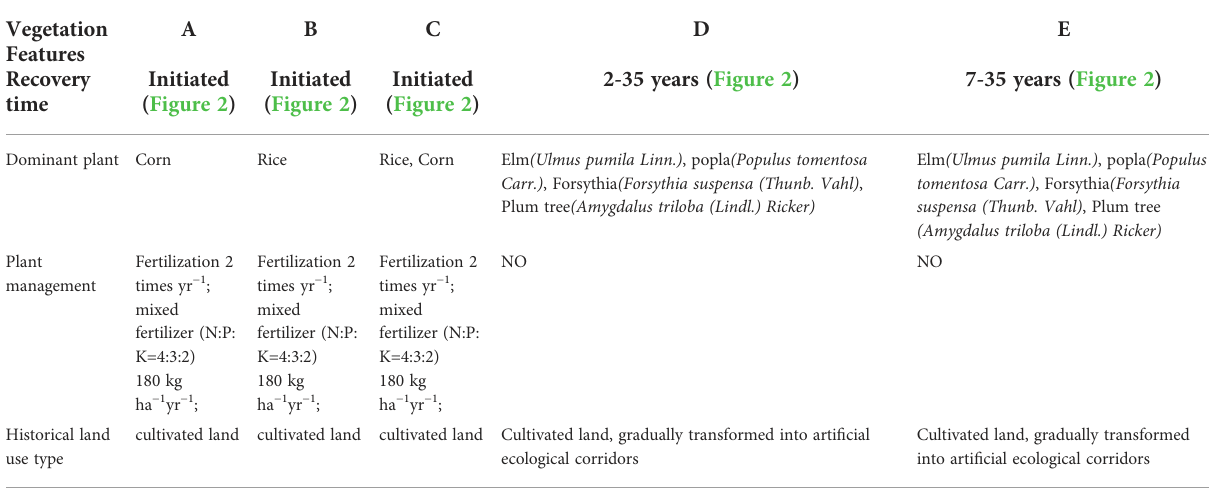
TABLE 1 Essential characteristics of the fi ve study plots.